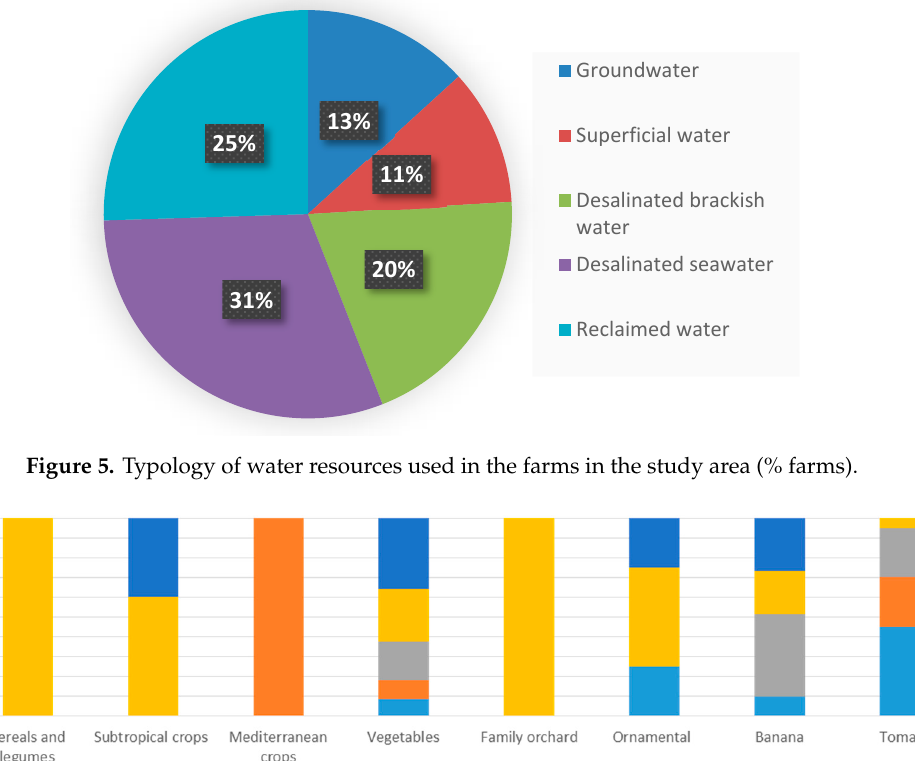
Figure 5. Typology of water resources used in the farms in the study area (% farms).